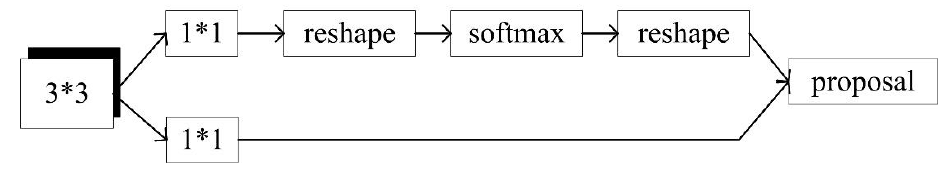
Figure 8. The Region Proposal Network .